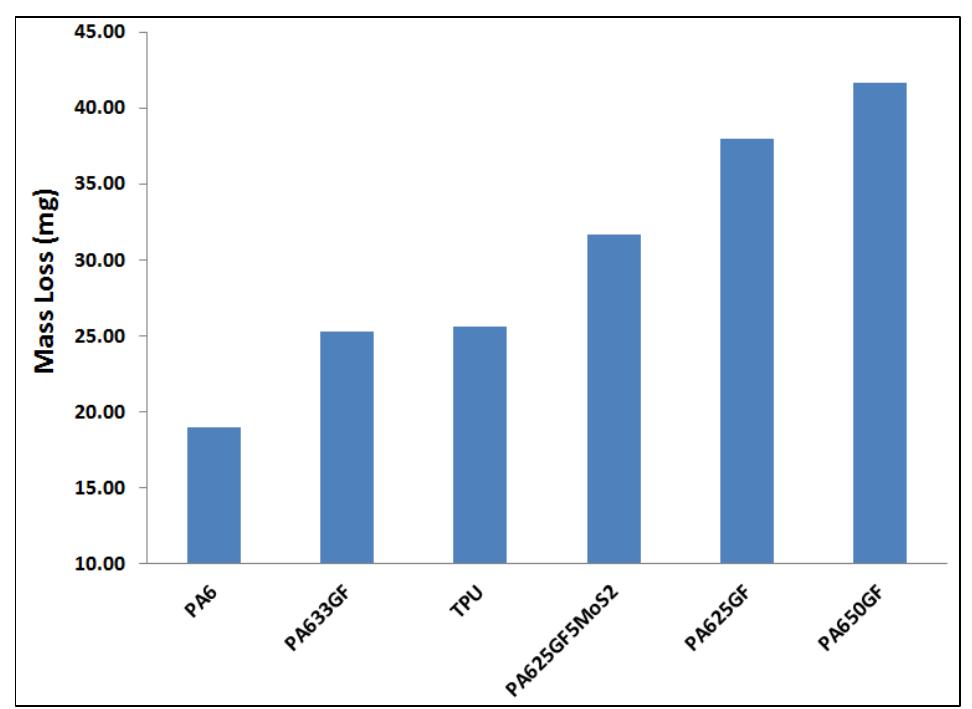
Figure 8. Mass loss values of the polymeric and composite samples after wear test.